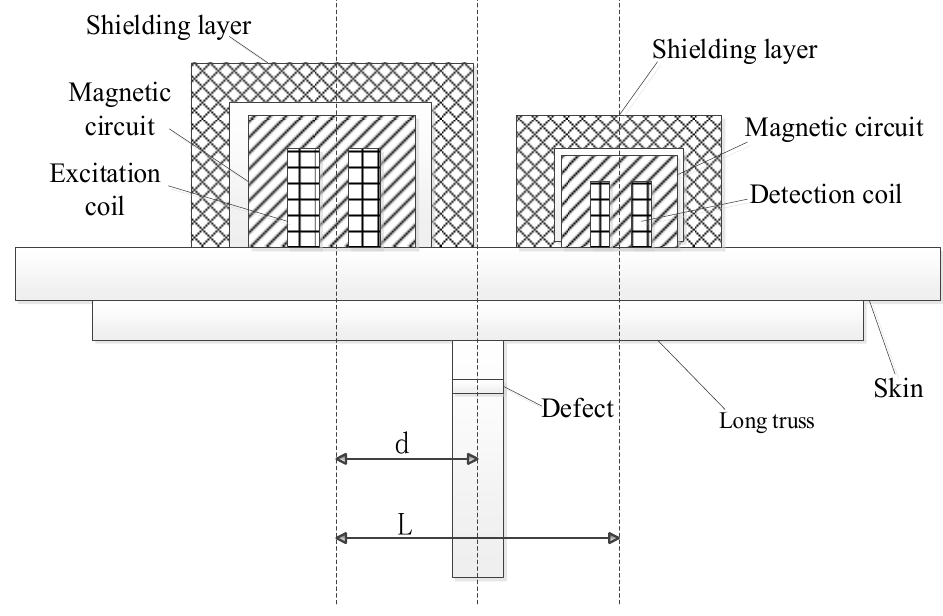
Figure 13. Schematic diagram of remote field eddy current testing method for aircraft long truss components.